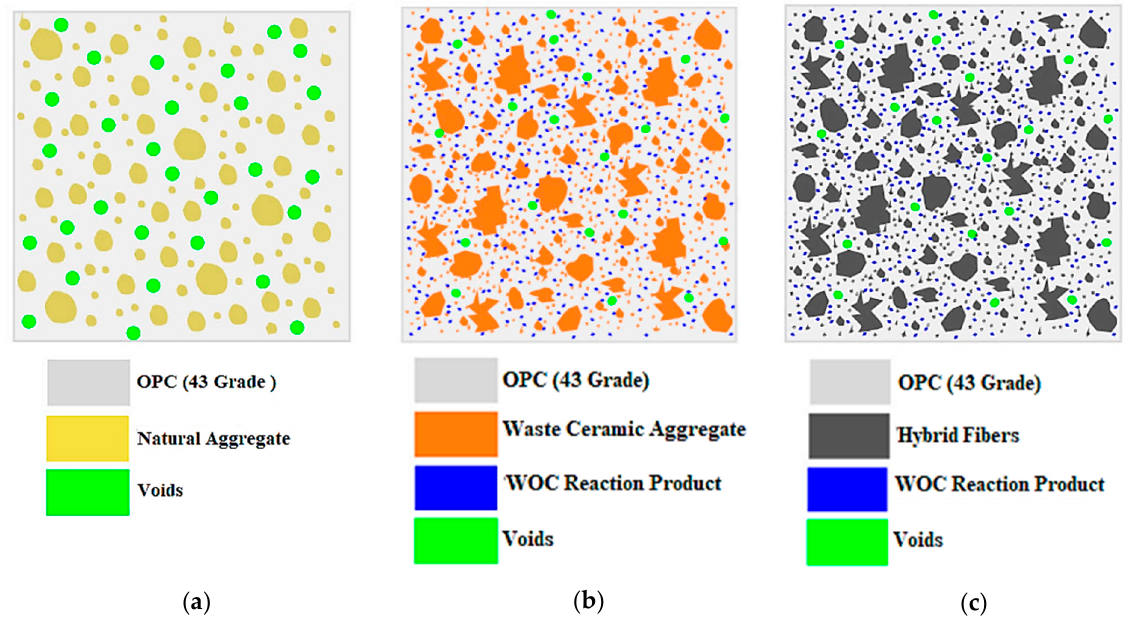
Figure 9. Conceptual diagram of the cross-section of ( a ) PC, ( b ) WOC, and ( c ) WOC-Hybrid concrete (dimensions are not to scale).